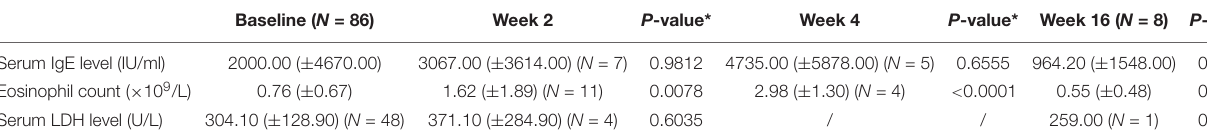
TABLE 4 | Laboratory test in patients with AD at baseline and follow-up after 2, 4, and 16 weeks.